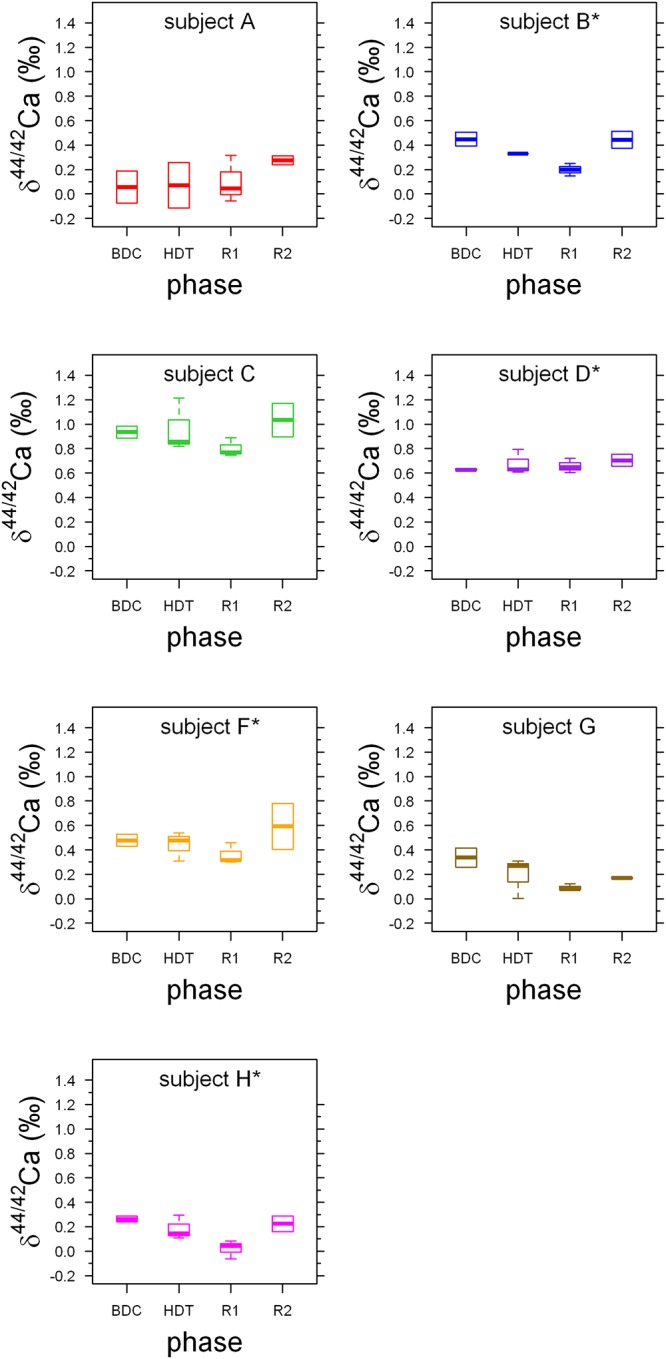
Boxplots of δ44/42Caurine values for each phase for the seven subjects A to H. Stars indicate subjects with KHCO3 supplementation. Phases are: BDC: pre-bed rest baseline data collection (BDC-6 and BDC-2), HDT: head down tilt bed rest (HDT2, HDT10, and HDT21), R1: post bed rest recovery (R + 0, R + 2, and R + 5) and R2: outpatient regeneration (follow-up examination; R + 14 and R + 28).